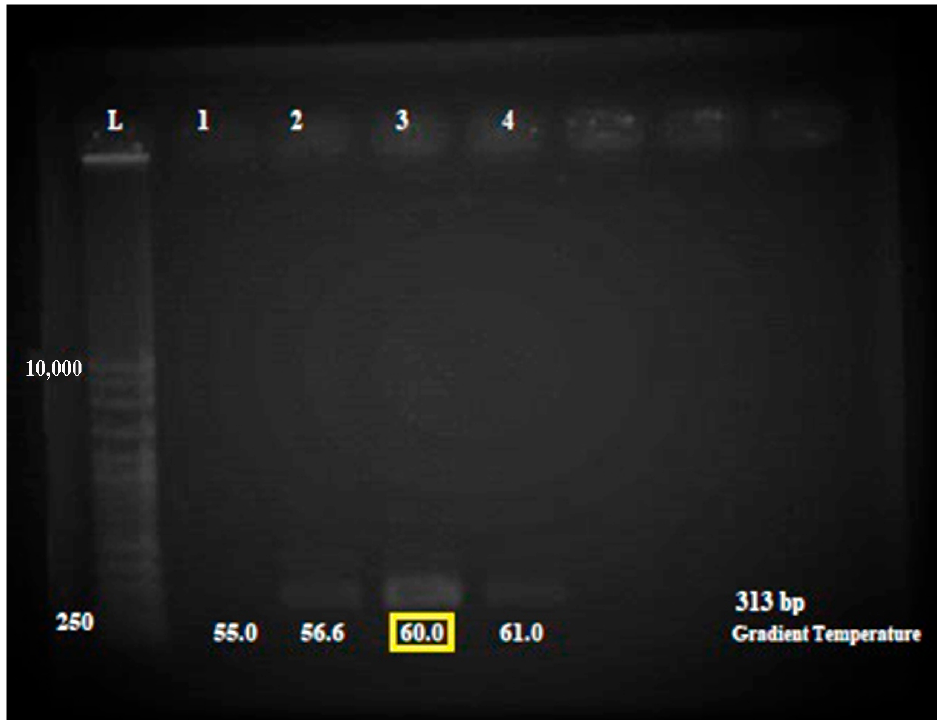
Figure 2. Electrophoresis gel (3% agarose) of the PCR products of the mecA gene for PCR optimiza- tion. The amplification optimized using MRSA isolates. Lane L = 1 kb ladder. The amplification of optimized isolate for annealing temperature 55.0 ◦ C, 56.6 ◦ C, 60.0 ◦ C, and 61.0 ◦ C. Lane 1 = amplifi- cation at annealing temperature 55.0 ◦ C, Lane 2 = amplification at annealing temperature 56.6 ◦ C, Lane 3 = amplification at annealing temperature 60.0 ◦ C, and Lane 4 = amplification at annealing temperature 61.0 ◦ C. A more apparent band was observed for the 60.0 ◦ C reaction as shown in